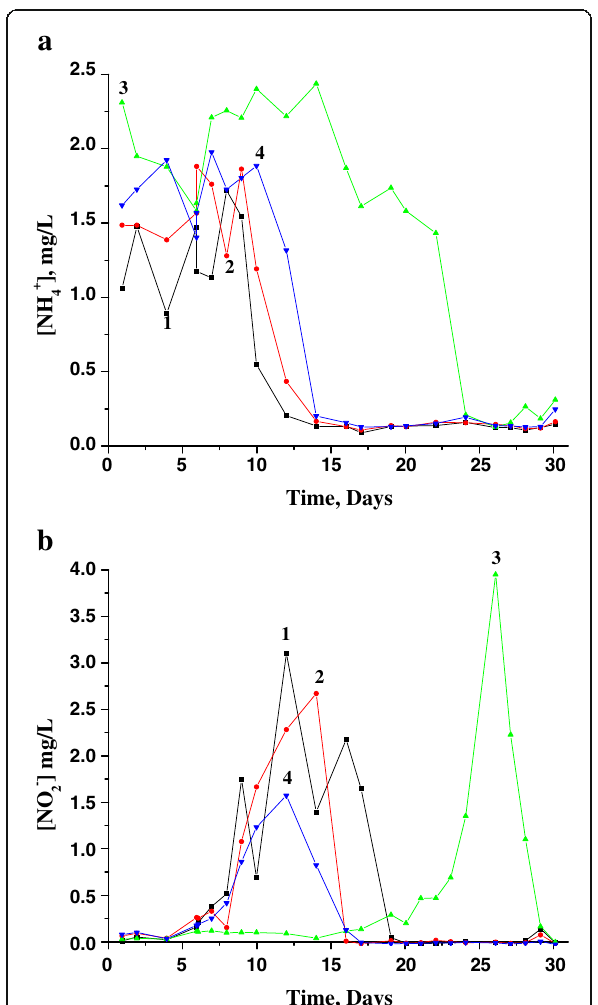
Fig. 5 Dynamics of ammonium ( a ) and nitrite ( b ) ion concentrations in the Isnovat River in the presence of CTMA, LS, and CaCO 3 nanoparticles. 1 — Reference sample. 2 — 10 − 5 mol/L LS . 3 — 10 − 5